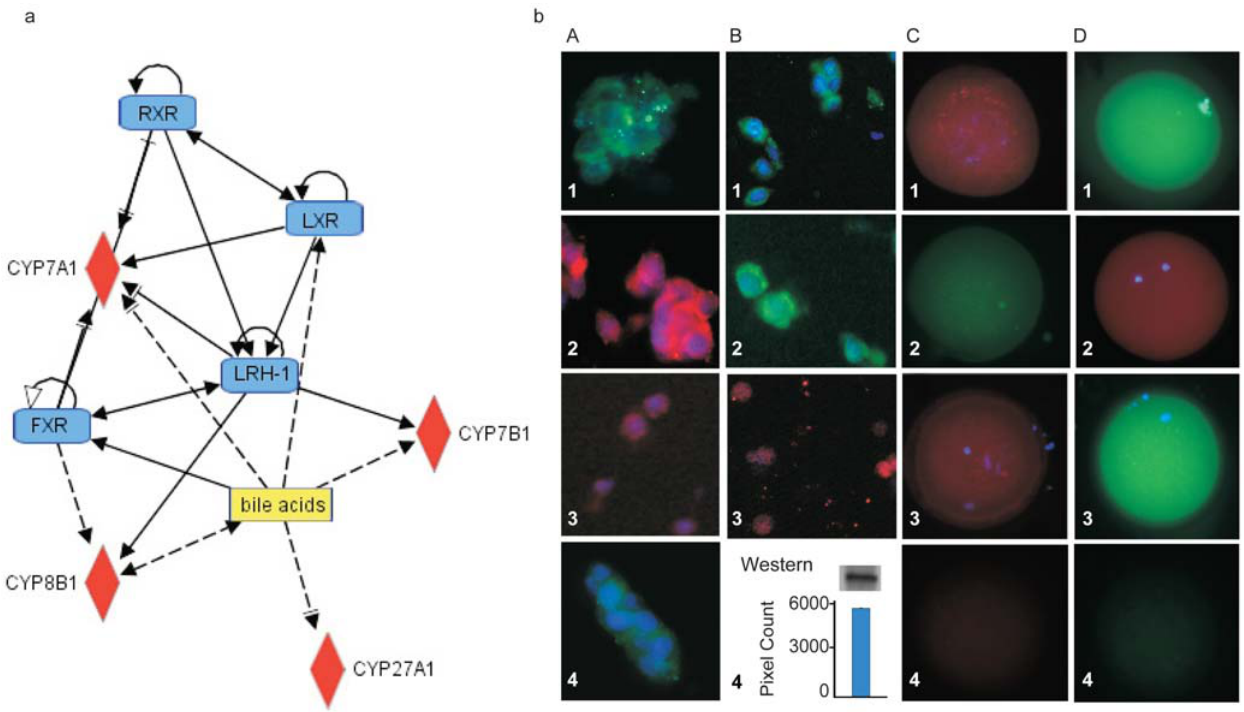
Figure 2. Presence of enzymes and receptors regulating the classical and alternative pathways of bile acid synthesis. In the cytosol of granulosa cells, specific positive staining was registered for CYP7A1 (Panel A, image 1), CYP27A1 (Panel A, image 2), and CYP7B1 (Panel A, image 3). Specific positive staining for Inhibin b was used to confirm granulosa cell type (Panel A, image 4). In oocytes, specific positive staining was identified for CYP7A1 (Panel C, image 1), CYP7B1 (Panel C, image 2), and CYP8B1 (Panel C, image 3). The receptors known to regulate the bile acid synthesis pathway were also present in granulosa cells and oocytes. In granulosa cells, specific positive staining was registered for FXR (Panel B, image 1), LRH-1 (Panel B, image 2), and RXR a (Panel B, image 3). Using western blot of granulosa cells, a specific reacting band for the receptor LXR a was observed (Panel B, image 4). In human oocytes, specific positive staining was also demonstrated for the receptors FXR (Panel D, image 1), RXR a (Panel D, image 2), and LRH-1 (Panel D, image 3). Secondary antibody controls are presented in images 4 of Panels C and D.